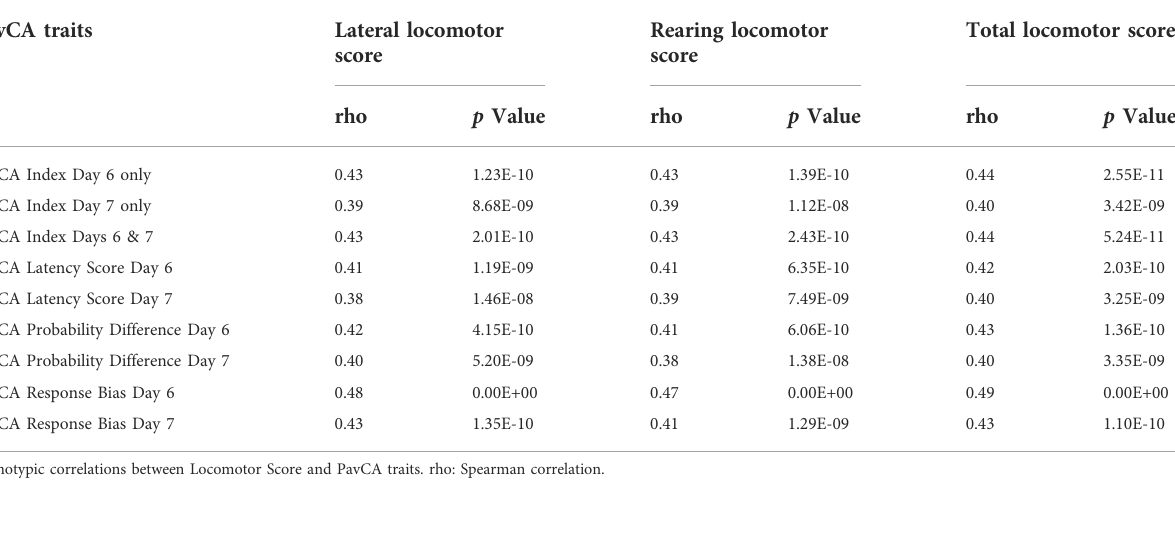
TABLE 3 Phenotypic correlations between Locomotor Score and PavCA traits.